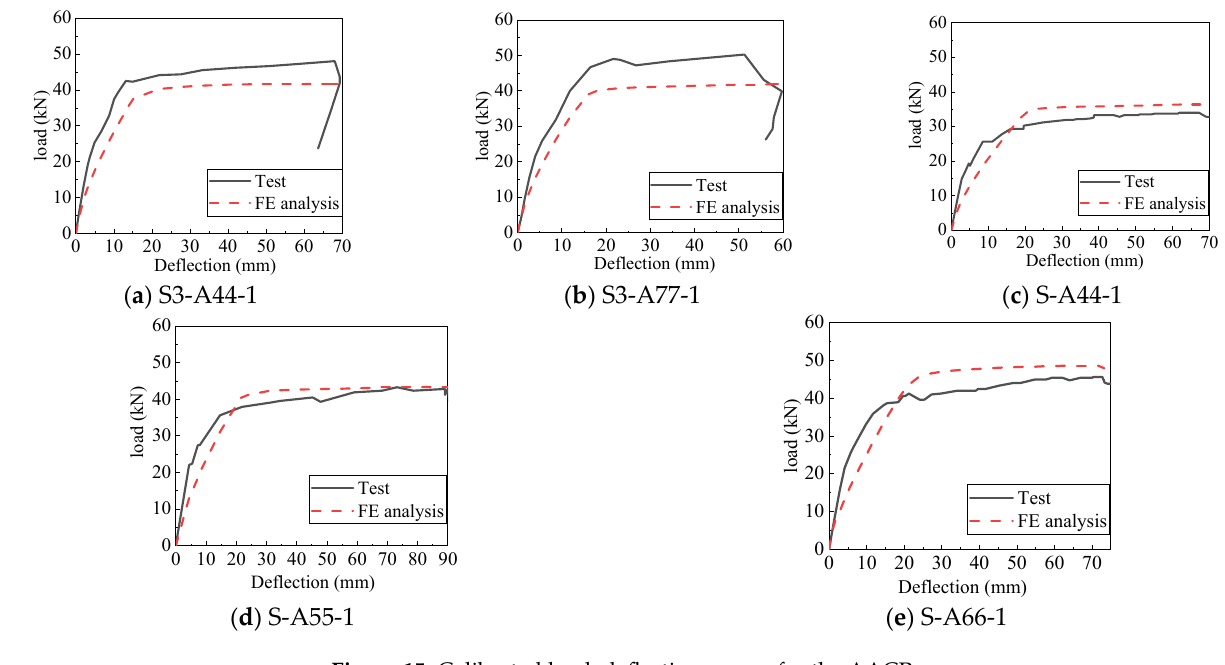
Figure 15. Calibrated load–deflection curves for the AACP.